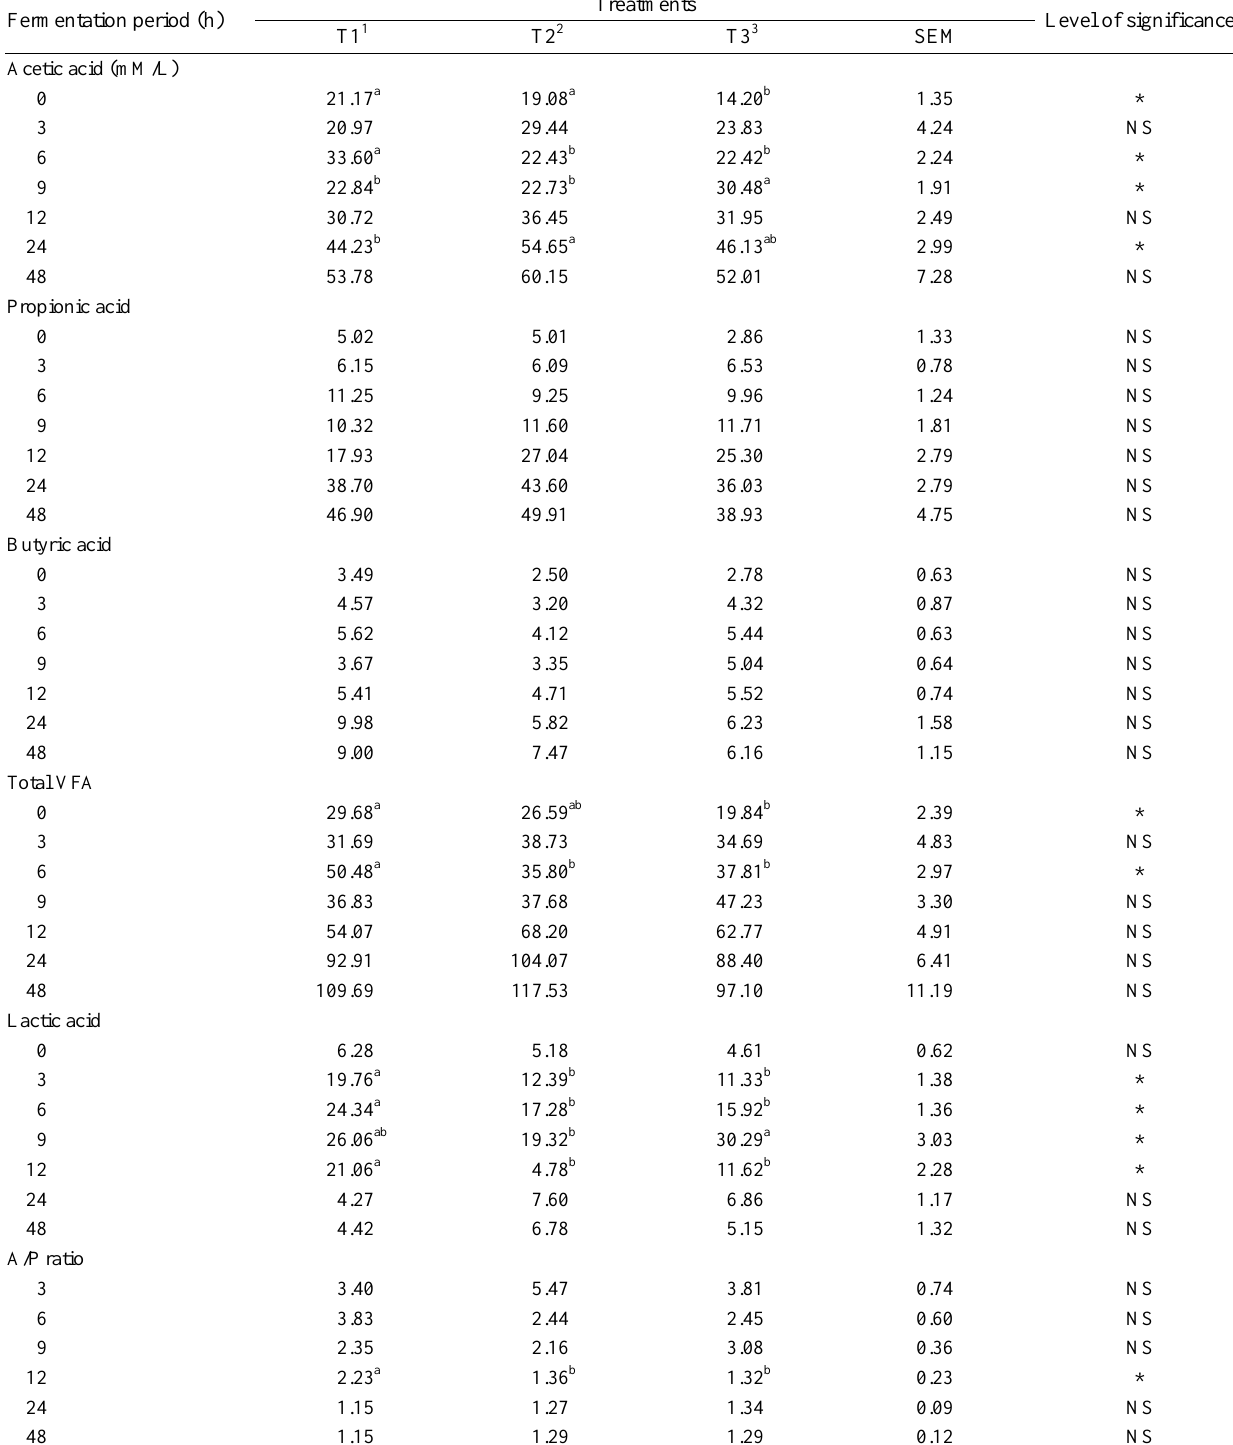
Table 3. Changes of VFA, lactate concentrations and A/P in in vitro fermentation of experimental diets at different incubation periods for Exp.